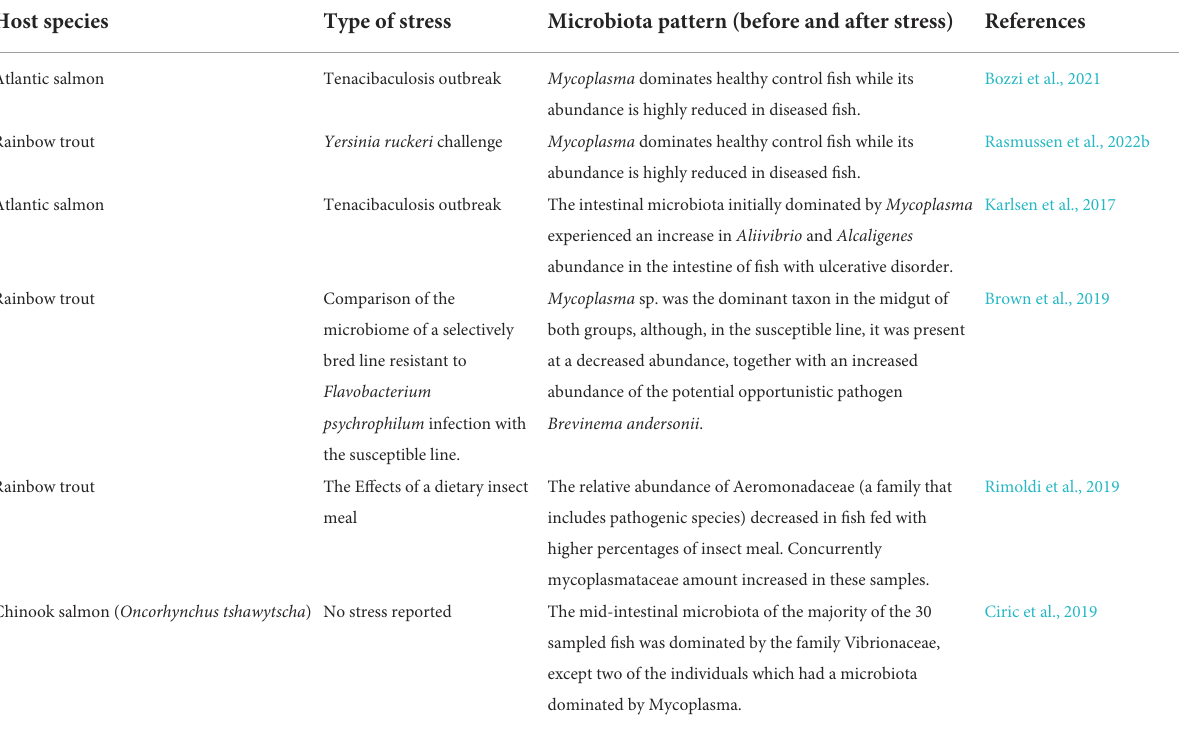
TABLE 1 A non-exhaustive list of relevant studies showing similar positive correlations with Mycoplasma sp. abundance and fish